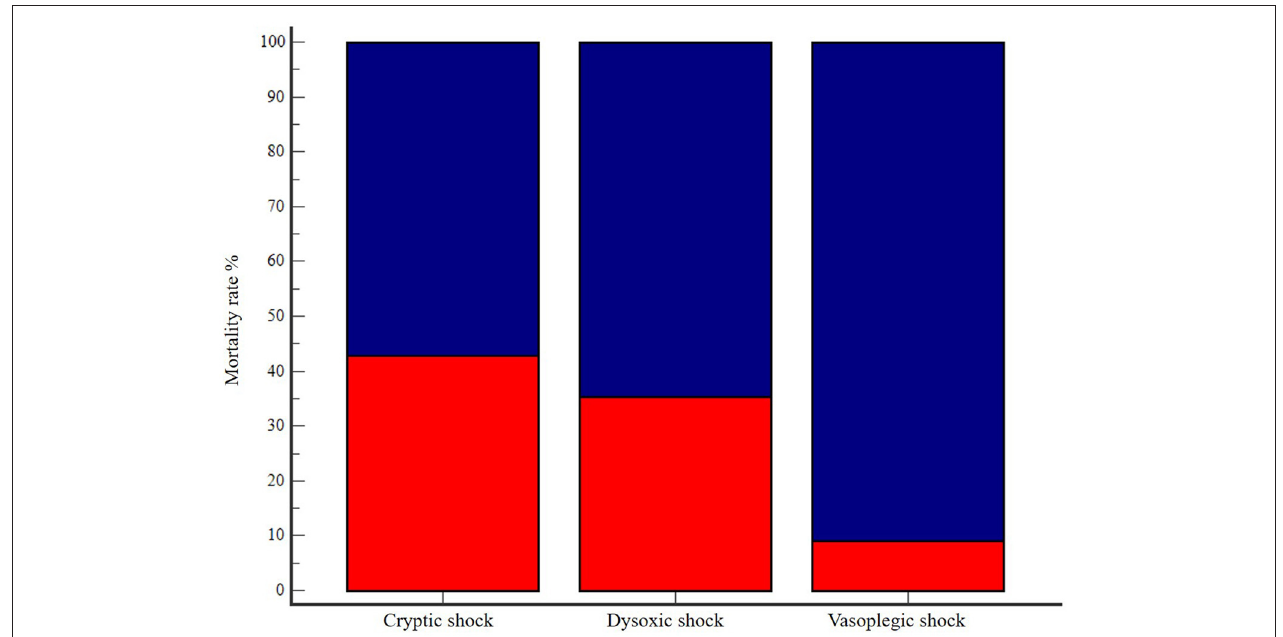
FIGURE 2 | Bar chart with 100% stacked columns showing mortality rate (in dark blue) in cats with cryptic shock ( n = 7, 57%), dysoxic shock ( n = 17, 65%), and vasoplegic shock ( n = 11, 91%). The difference was not statistically significant ( P = 0.09).